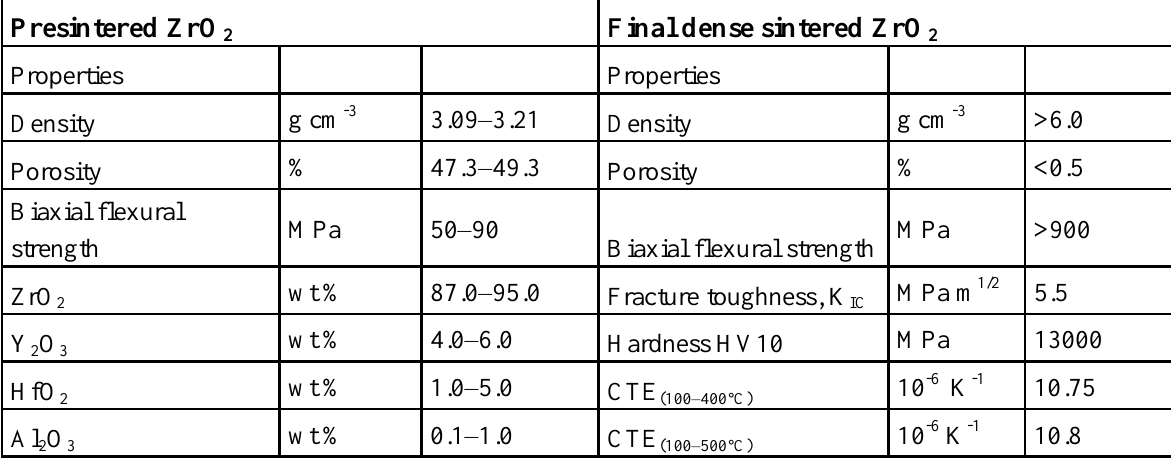
Table 2 . Properties of IPS e.max  ZirCAD, Ivoclar Vivadent AG; in the presintered and final sintered state, including chemical